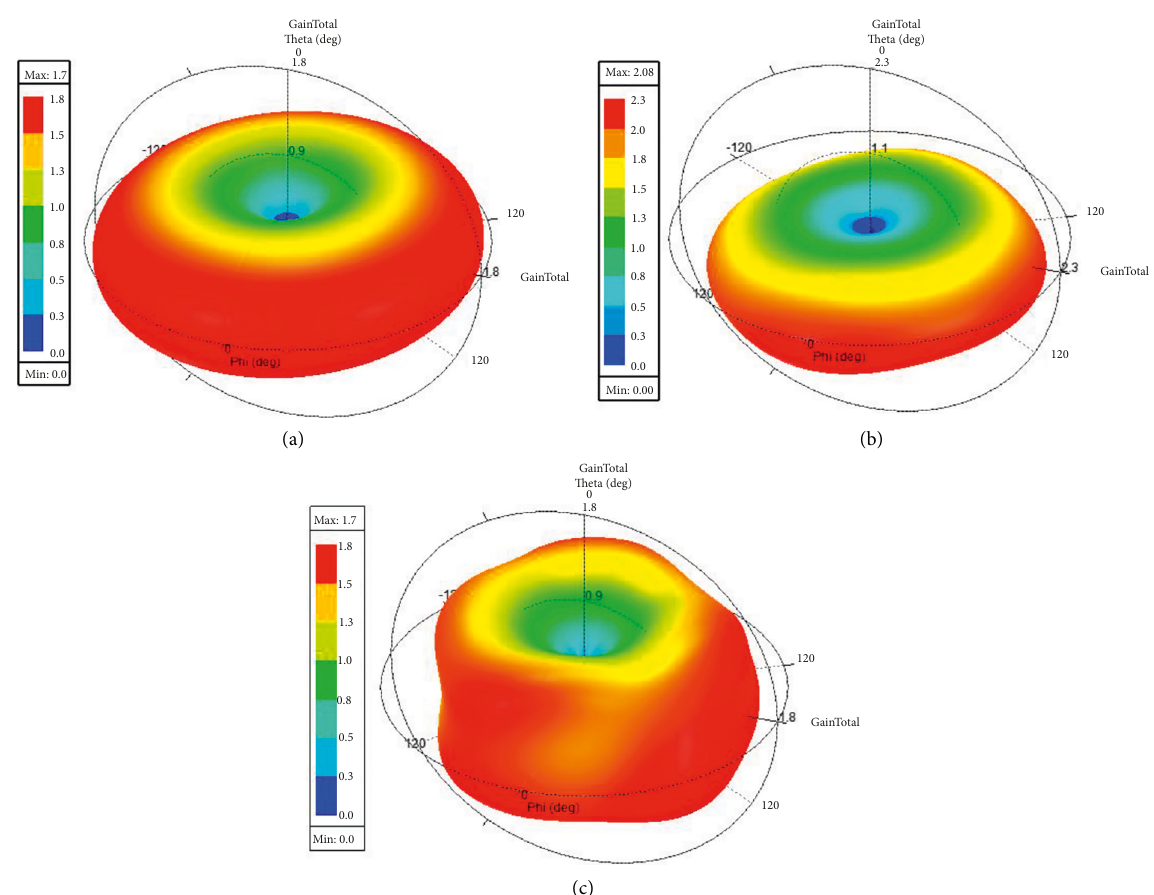
Figure 8: The 3D radiation patterns of the proposed antenna. (a) 200MHz, (b) 350MHz, and (c) 500